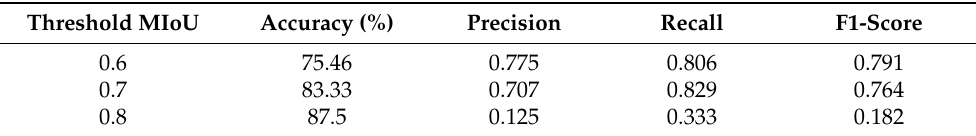
Table 17. Failure detection results of the selected network structure for the Hyundai Motor Group (HMG)